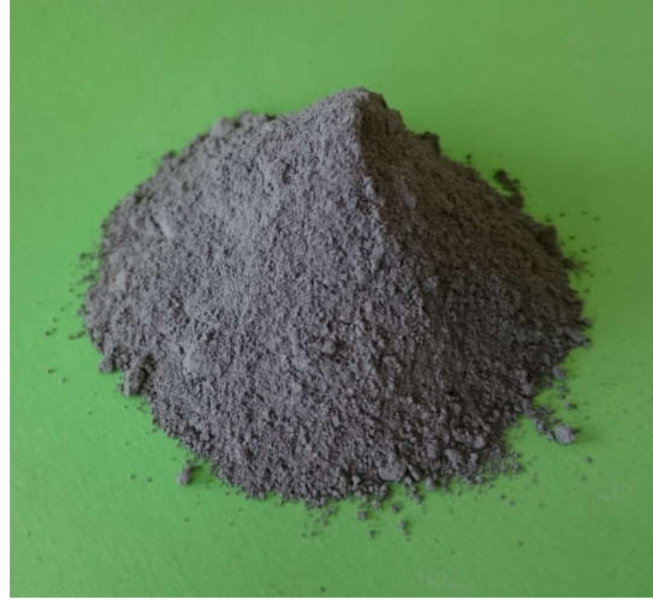
Figure 2. Sample of rinsed MUD (RMUD) prepared for tests.